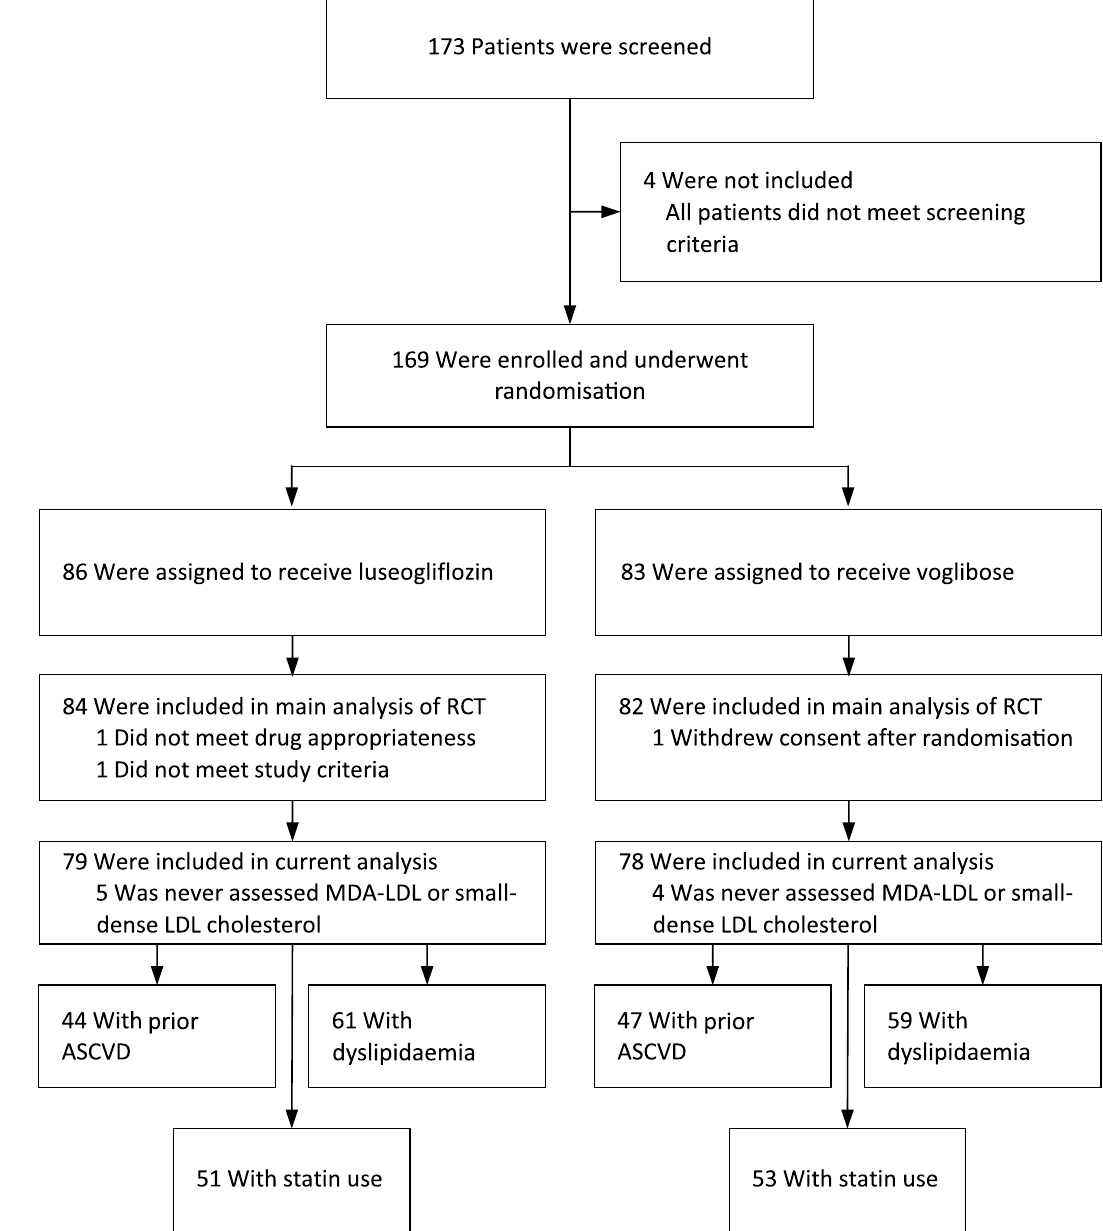
Figure 1. Study flow diagram. RCT randomised-controlled trial, MDA-LDL malondialdehyde low-density lipoprotein, ASCVD atherosclerotic cardiovascular